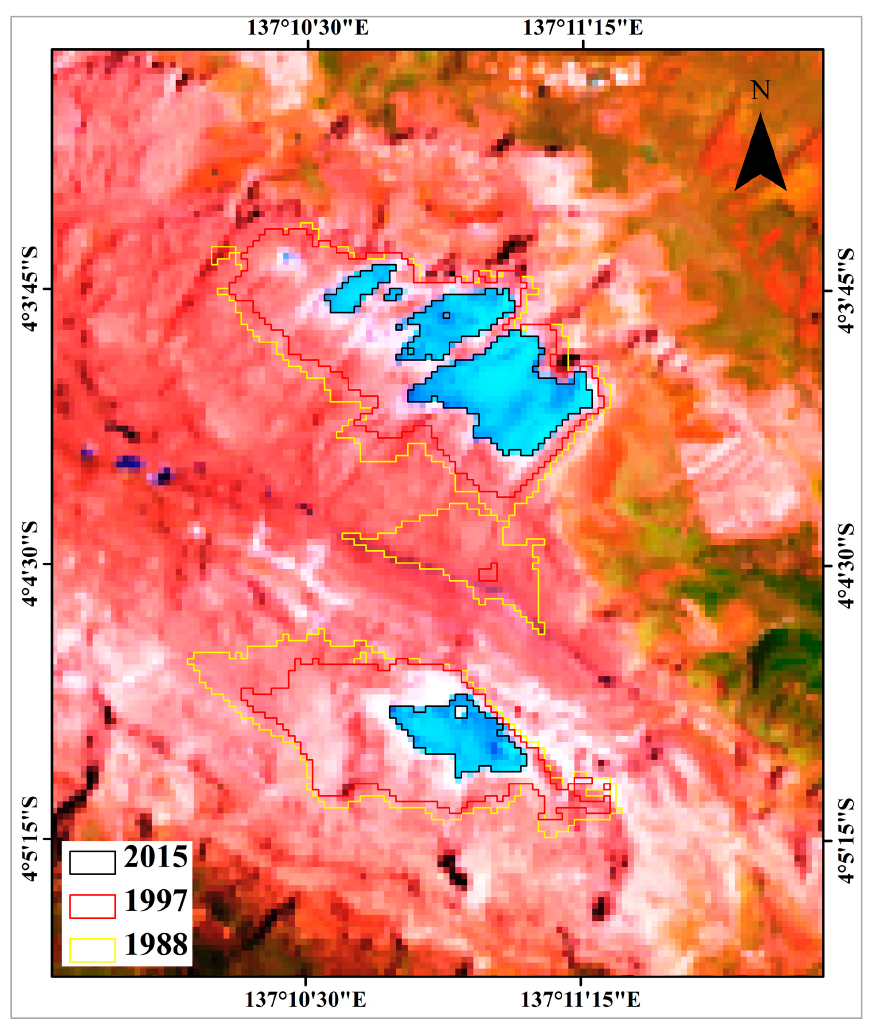
Figure 4. Glacier recession of glaciers in Papua in Australasia between 1988 and 2015.